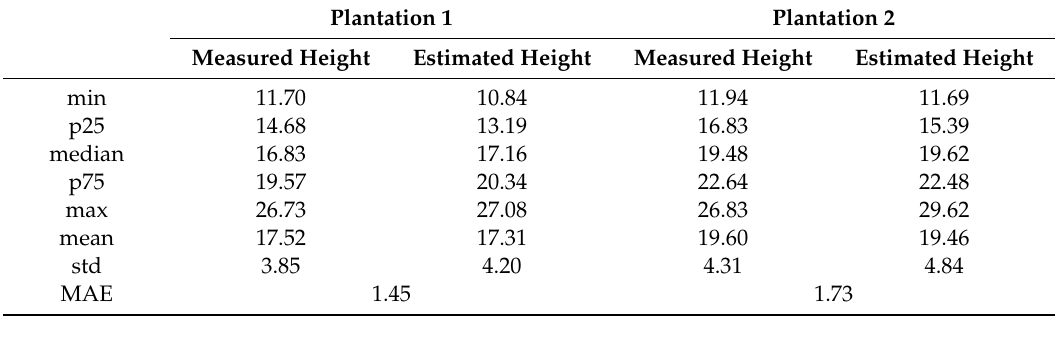
Table 4. Comparison of the measured and estimated height variables (unit: m) for the two forest plantations at the tree level. 0% (min), 25% (lower), 50% (median), 75% (upper), and 100% (max) are the quartiles that are used to extract the tree heights at the corresponding percentiles. std denotes the standard deviation of tree heights.